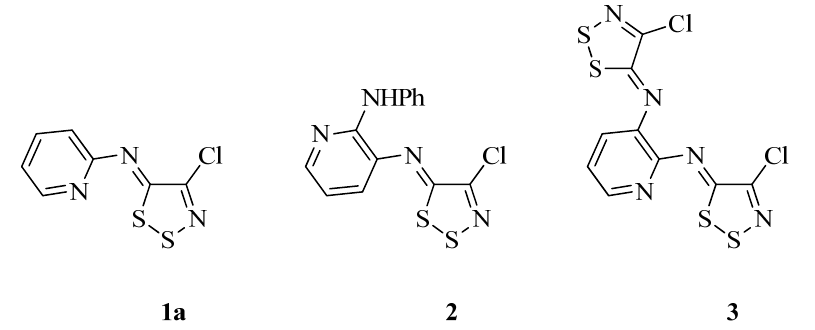
Figure 1. Structures of known N -(4-chloro-5 H